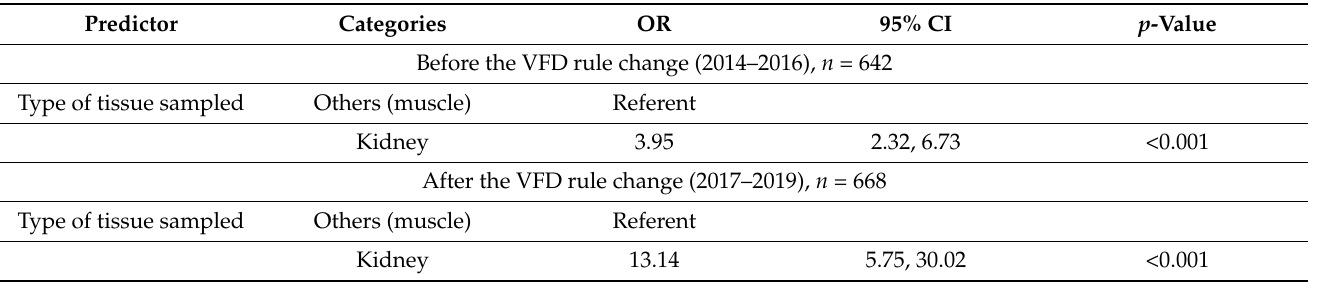
Table 5. Results of association between type of tissue sampled and penicillin residues in the tissue of food animals by VFD rule change categories.